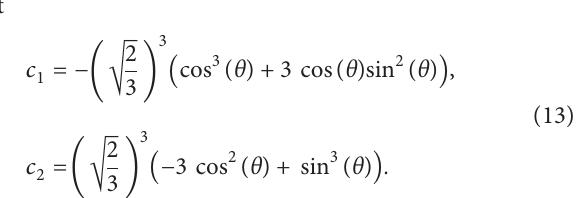
Figure 10: The general Mandelbrot set P � √ (− i / , 0 ) . 3